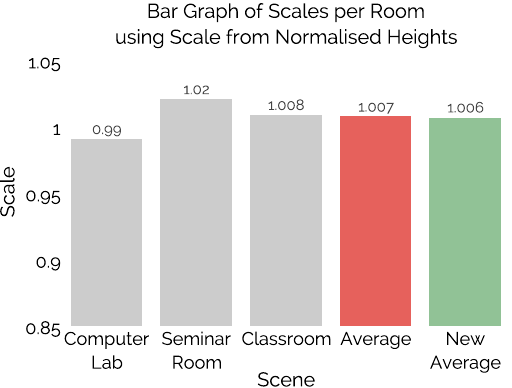
Figure 8: Bar graph illustrating the effect of applying a scale of 1.007 to each scene.